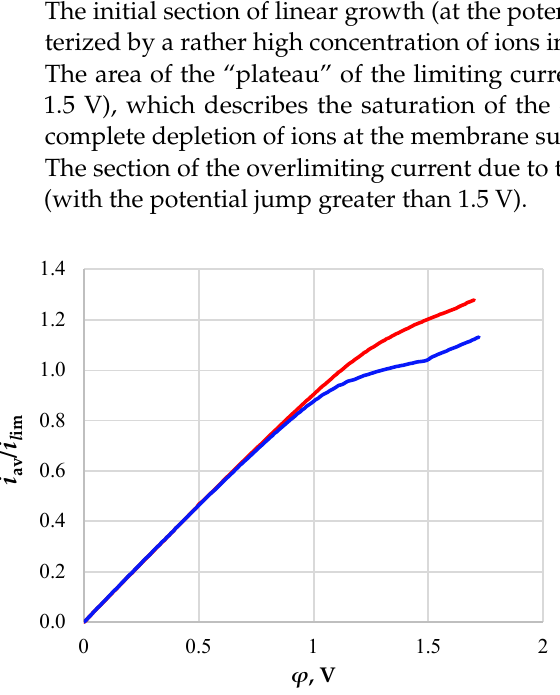
Figure 2. CVCs calculated for the desalination channels of an electrodialysis apparatus with NaCl solution without a spacer (blue line) and with a spacer insert in the center of the channel (red line). In the considered range of potential jump values (from 0 to 1.7 V), the flow in the case without a spacer is irrotational in the entire desalination channel (Figure 3a), except for a narrow region (of the order of 20 µ m) near the cation-exchange membrane in which electroconvective vortices are